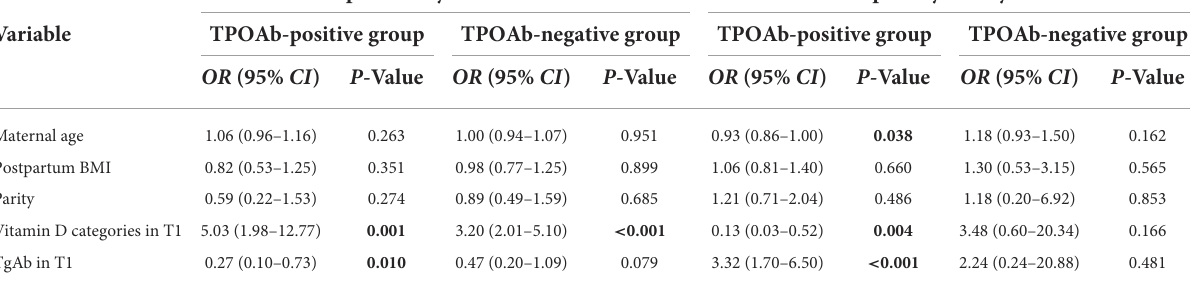
TABLE 6 Multivariate Cox regression analysis of thyroid function in the 12th month